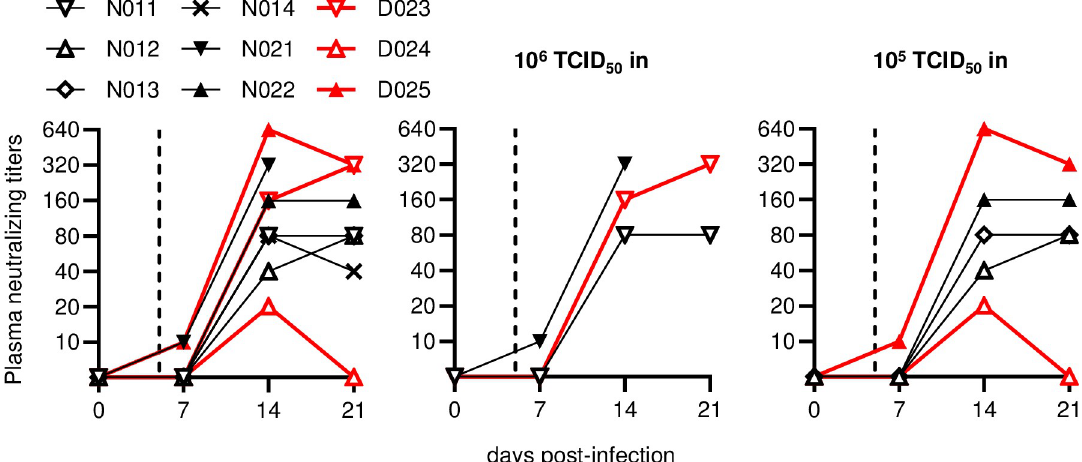
Fig 4. SARS-CoV-2-specific neutralizing antibody responses. Changes in plasma anti-SARS-CoV-2 neutralizing antibody titers post- infection in all animals (left) or those infected with 10 6 (middle) or 10 5 (right) TCID 50 of SARS-CoV-2.